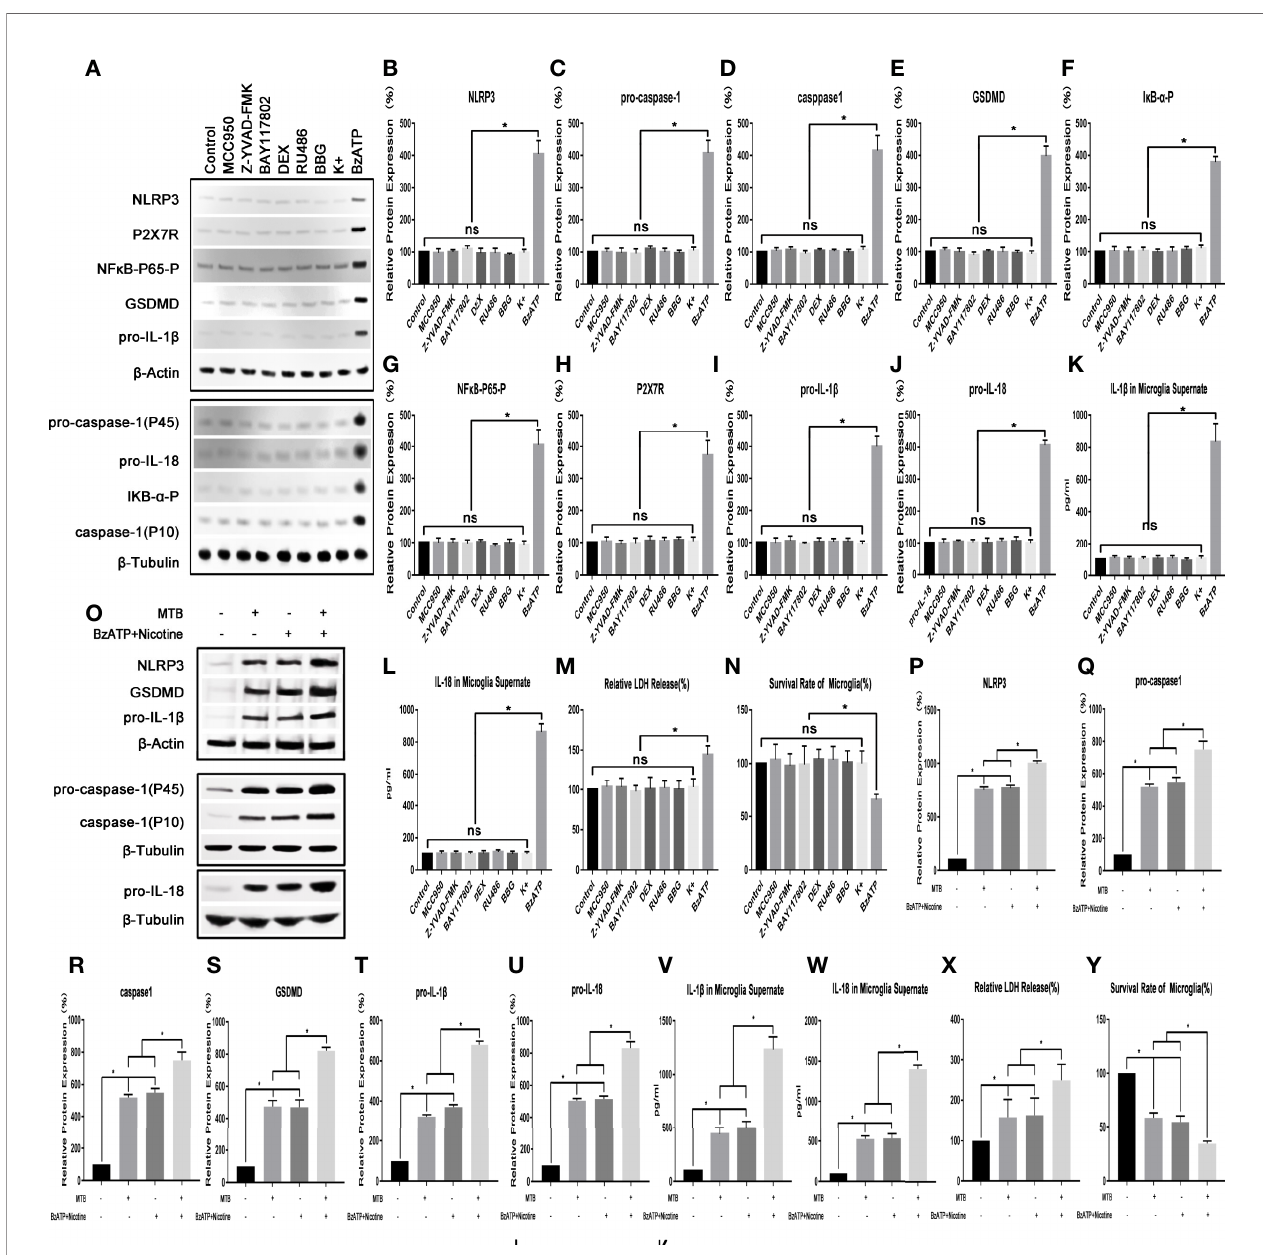
FIGURE 1 | Observe the changes of NLRP3 in fl ammasome pathway and survival rate of microglia. (A – N) The in fl uence of various inhibitors and agonists on microglia. Except for BzATP, the related drugs used in this experiment have no signi fi cant effect on the NLRP3 in fl ammasome pathway and survival rate of microglia under normal conditions. (O – Y) The effect of Mtb H37Ra and nicotine+BzATP on the NLRP3 in fl ammasome pathway in microglia. NLRP3 in fl ammasome pathway in microglia can be activated by the Mtb H37Ra strain, and its effect is similar to nicotine + BzATP, and the effect is more obvious when the two are used in combination. (*P < 0.05. ns, no signi fi cant